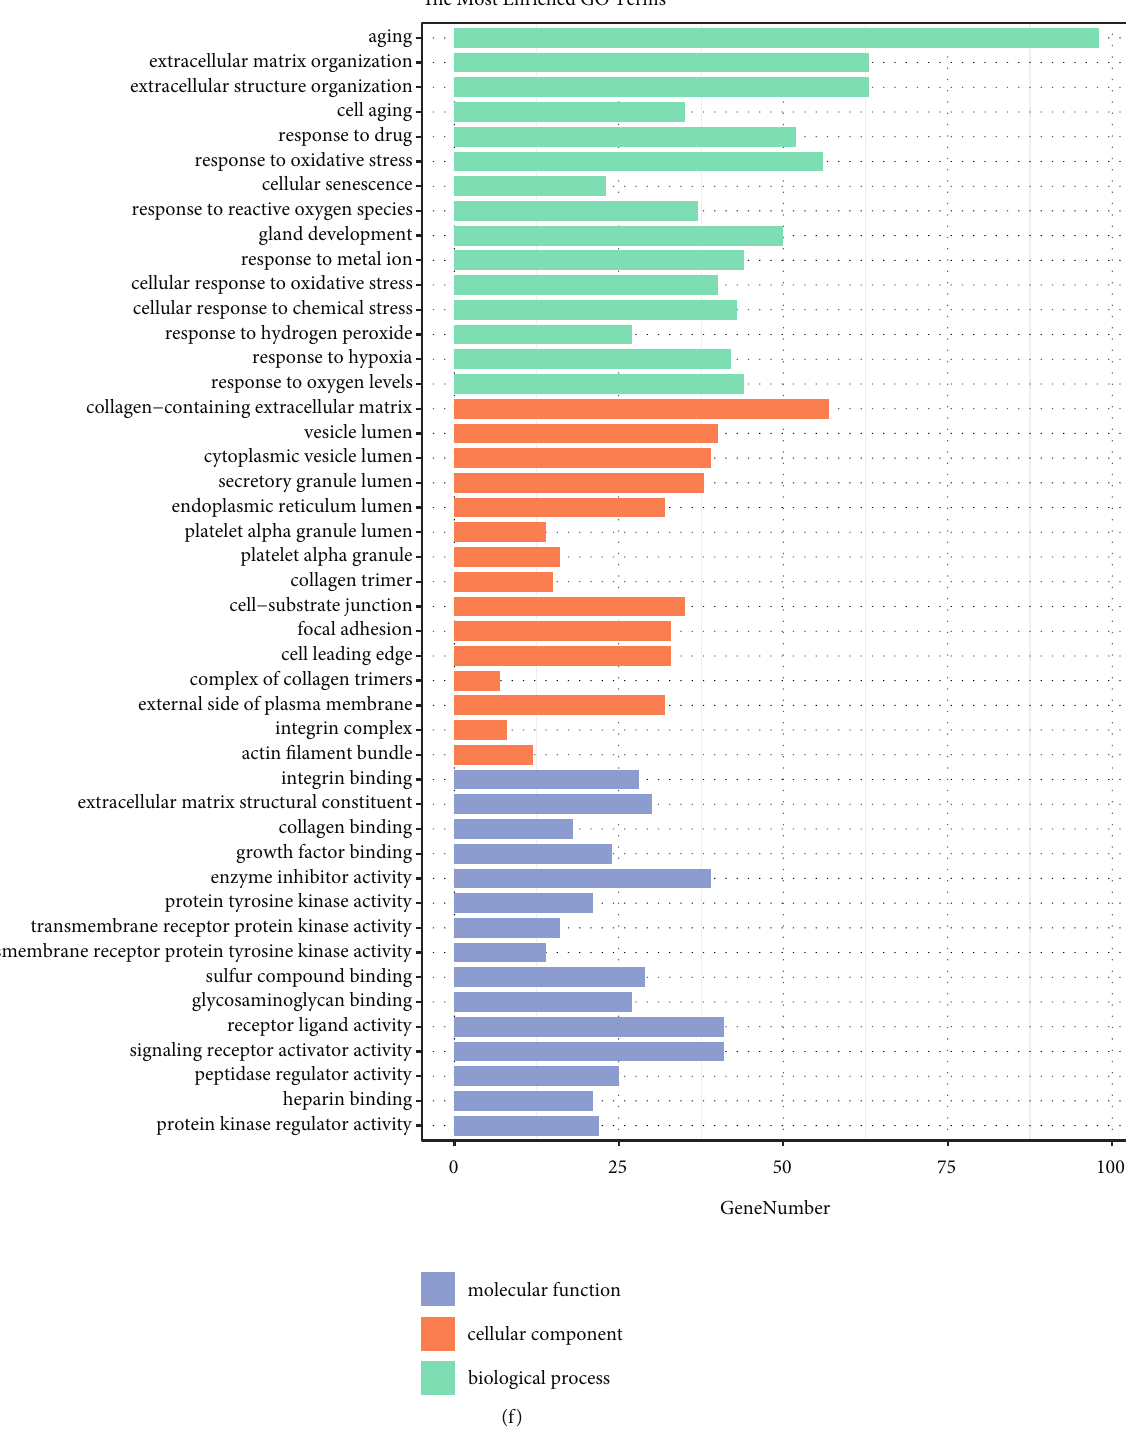
Figure 2: Di ff erence between tumor and normal samples of merged data. (a) PCA on the merged dataset for dimensionality reduction and quality control. (b) Volcano plot of the di ff erentially expressed genes. The X coordinate is |log2(fold change)| and the Y coordinate was -log 10(p value). Each dot represents a gene. Red dots are the upregulated genes of signi fi cant expression. Green dots are downregulated genes of signi fi cant expression. Black dots are genes of nonsigni fi cant di ff erence. (c) Expression heat map of di ff erential genes. (d) 1611 overlapped ARGs obtained from TCGA dataset, GSE44001 dataset, and aging-related gene sets. (e) The heat map of DE-ARGs. (f) Gene ontology (GO) functional enrichment shows that the DE-ARGs were mostly enriched in several important biological processes including aging, cell aging, and response to oxidative